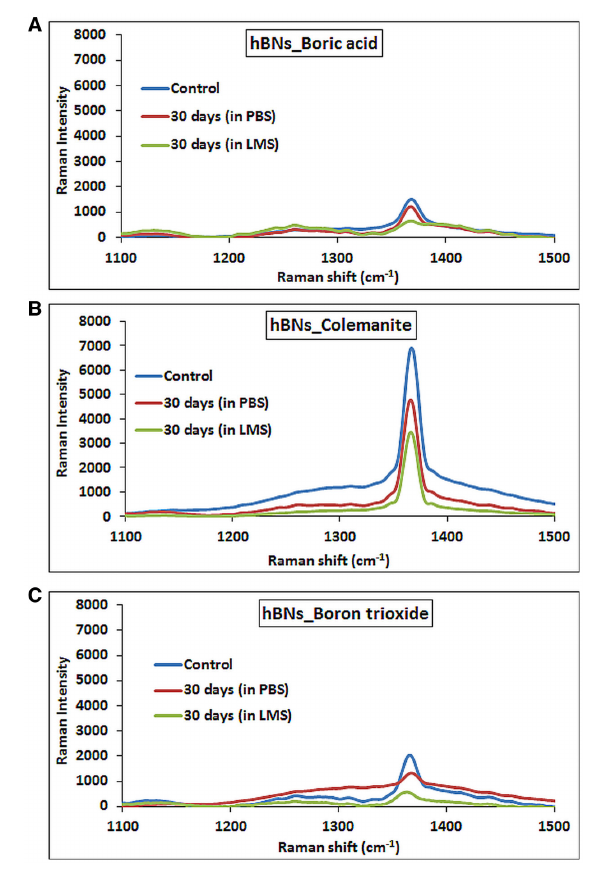
FIGURE 6 | ICP-MS results of hBNs in LMS and PBS suspensions at increasing time points during biodegradation process. (A) hBNs_boric acid, (B) hBNs_colemanite, and (C) hBNs_boron trioxide.